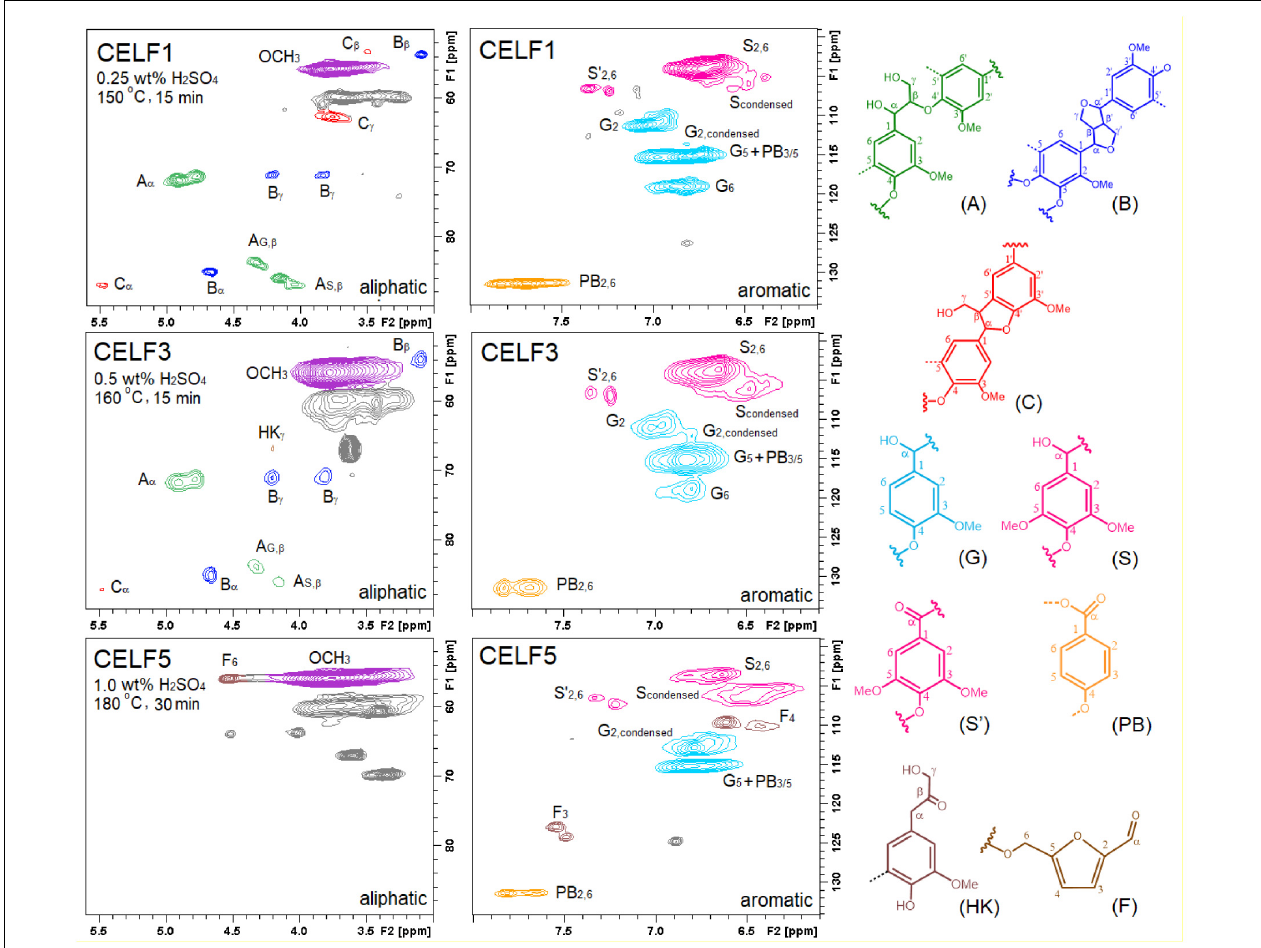
FIGURE 3 | HSQC spectra of CELF1, 3 and 5. Structure (A) β – O –4 (cid:48) linked alkyl aryl ether substructure; (B) β – β (cid:48) linked resinol substructure; (C) β –5 (cid:48) and α – O –4 (cid:48) linked phenylcoumaran substructure; (G) guaiacyl unit; (S) syringyl unit; (S (cid:48) ) oxidized syringyl unit; (PB) p –hydroxybenzoate substructure; (HK) Hibbert ketone; (F) etherified 5-(hydroxylmethyl)